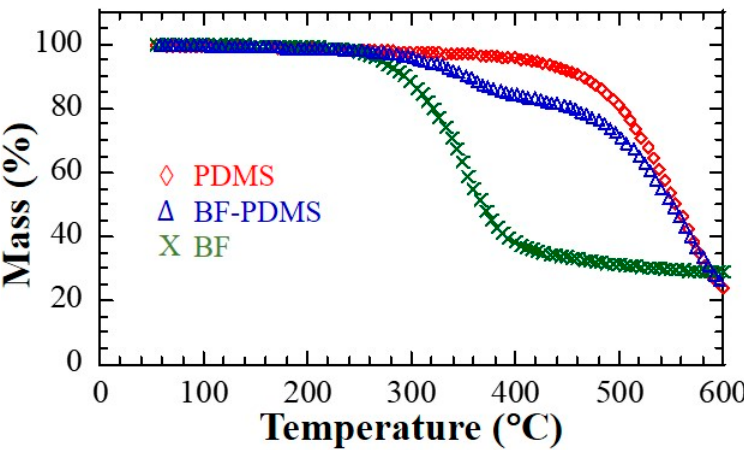
Figure 6. Thermogravimetric analysis (TGA) curves of bamboo fiber (BF), bamboo fiber-reinforced polydimethylsiloxane (BF-PDMS), and polydimethylsiloxane (PDMS) under N 2 atmosphere at the heating rate of 10 °C/min.